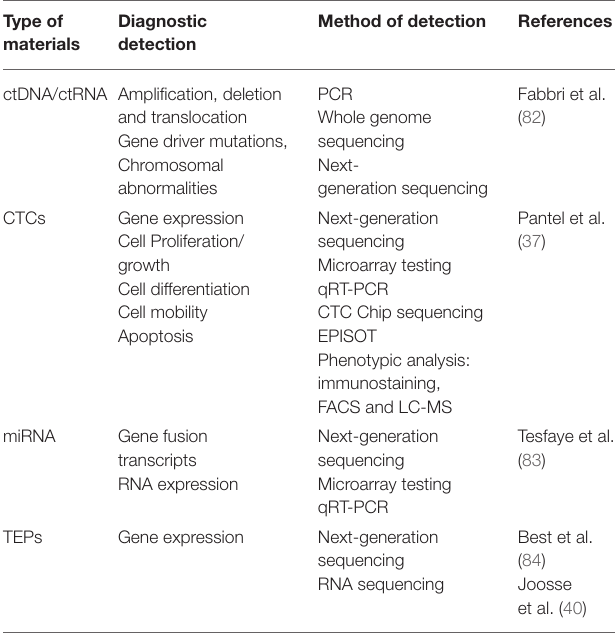
TABLE 1 | Sampling materials and methods of clinical application with PDAC